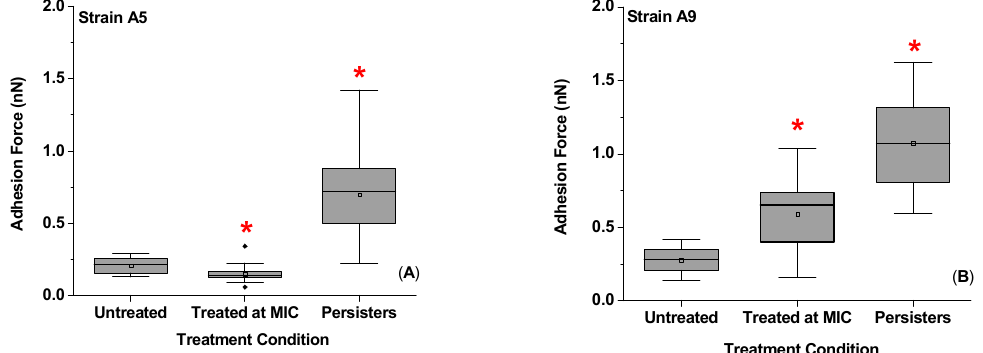
Figure 6. A summary of the average AFM nanoscale adhesion forces (F ad ) measured between the Si 3 N 4 cantilever and the bacterial surface biopolymers: ( A ) for A5; and ( B ) for A9. ( A ) For Strain A5, 816, 260, and 273 adhesion point were plotted, respectively. ( B ) For Strain A9 the average of 205, 91, and 41 adhesion points were plotted, respectively. * Values are statistically significant from the control and treatment group at p < 0.001, n = 3 independent cultures.